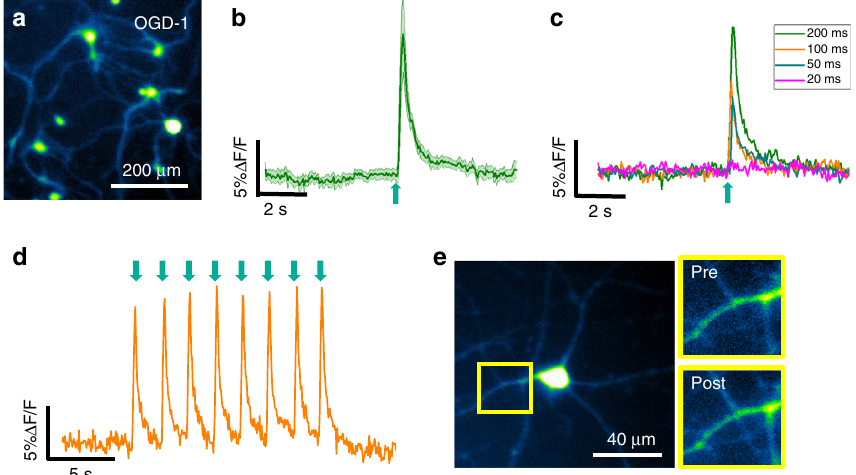
Fig. 2 FOC induces calcium transients in cultured primary neurons. a Neurons loaded with OGD-1. b The average trace of neuronal calcium trace ( n = 12) in response to 200 ms FOC stimulation. Shaded area: ± SD. c Representative traces of neuronal response to 200-ms, 100-ms, 50-ms, and 20-ms FOC stimulation. d Calcium trace of a neuron undergone repeated FOC stimulations. e Representative image of a neuron before and after repeated FOC stimulations. Green arrows: stimulation onset. Source data are provided as a Source Data fi